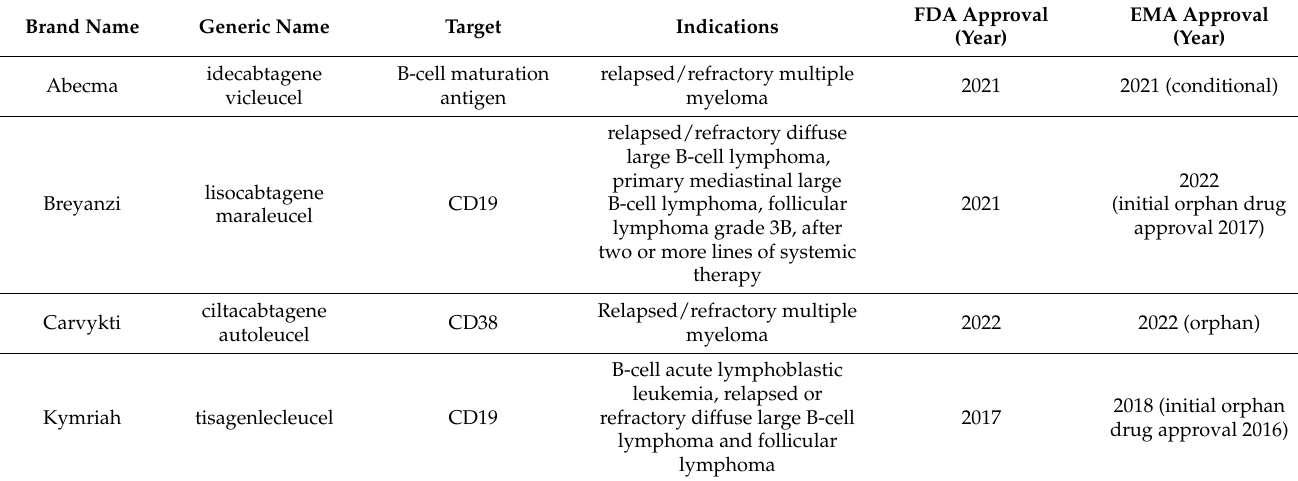
Table 1. Current FDA/EMA approved CAR-T